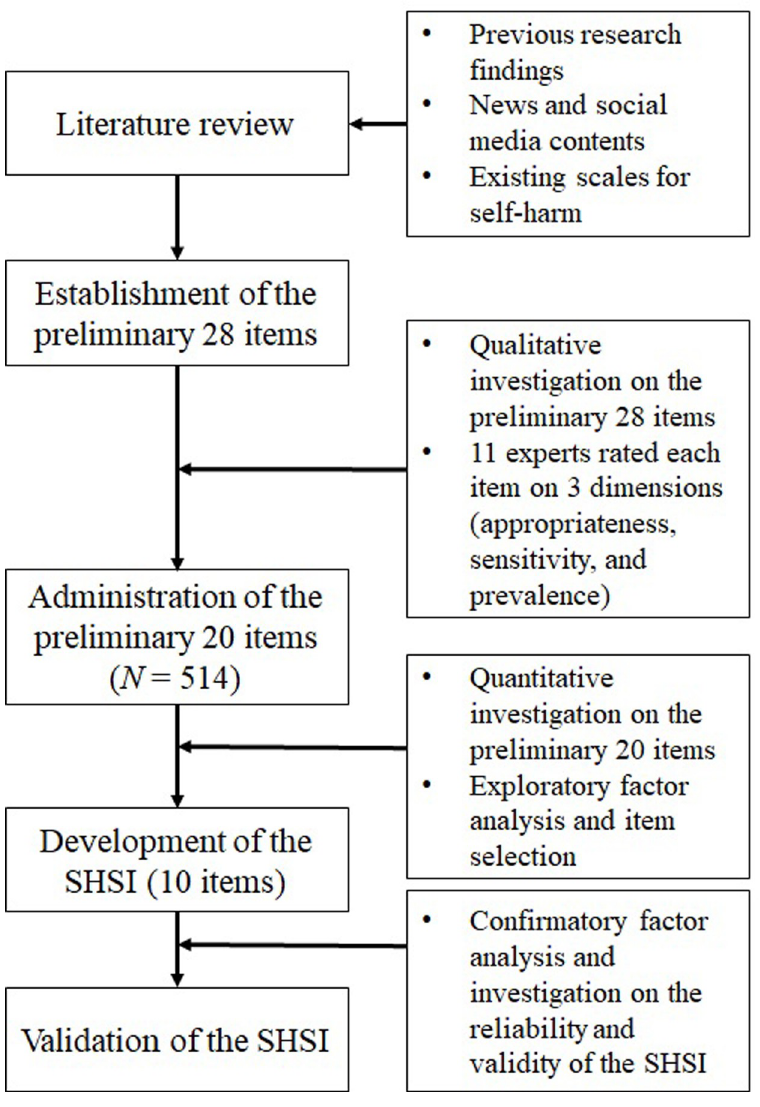
Fig 1. Flow of the